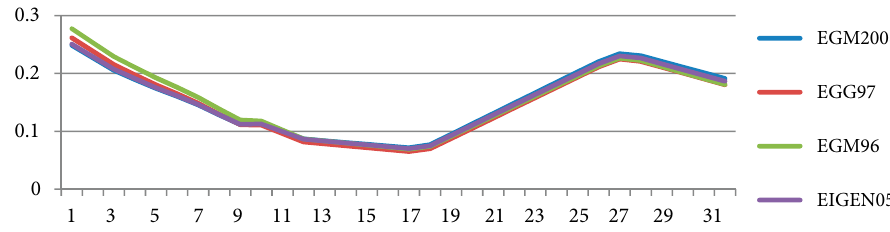
Fig. 8. Deviation of geoid heights N(m) from actual DEM a latitude 42.90